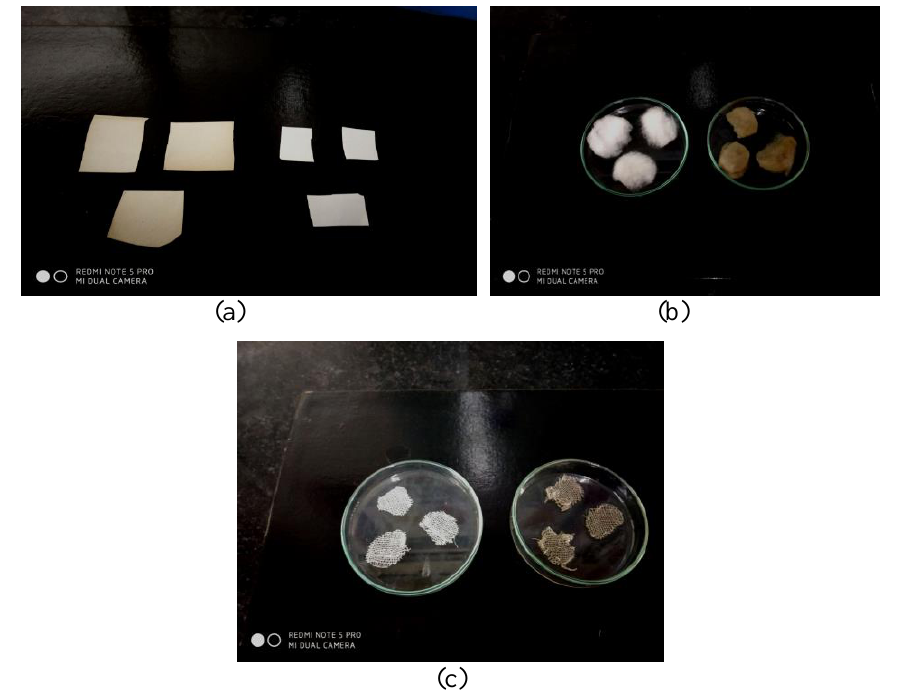
Figure 7. Dyed objects: (a) Paper: Pre (L) and After dyeing (R) (b) cotton: Pre (R) and After dyeing (L) and (c) Cloth: Pre (R) and After dyeing (L)